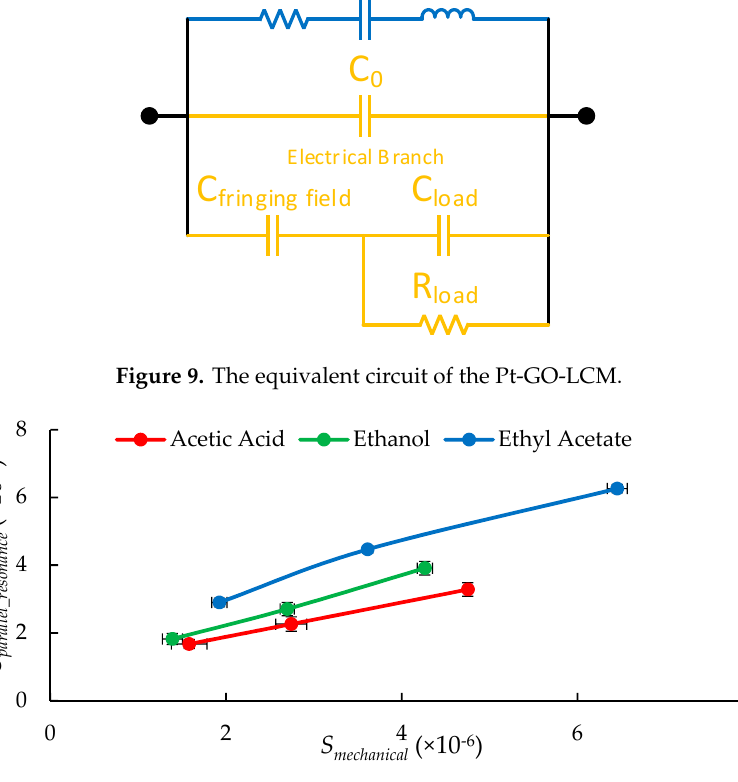
Figure 10. Plot of sensitivity of series versus parallel resonant frequencies for a change in flow ratio of VOC gas over the Pt-GO-LCM indicating the selectivity property of the sensor to discriminate the VOC species under study.